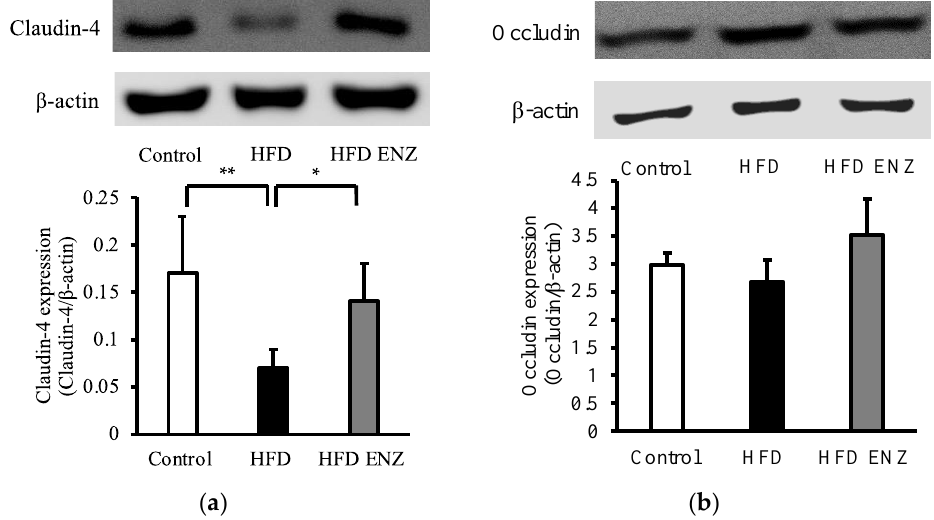
Figure 3. Expression of adhesion molecules in intestinal mucosa. Expression of ( a ) claudin-4 and ( b ) occludin in intestinal mucosa as analyzed by immunoblotting and compared between control mice (control), mice fed with high-fat diet (HFD), and Enzamin-treated mice fed with high-fat diet (HFD ENZ). Data are shown as mean ± SD, n = 6, * p < 0.05, ** p < 0.01.